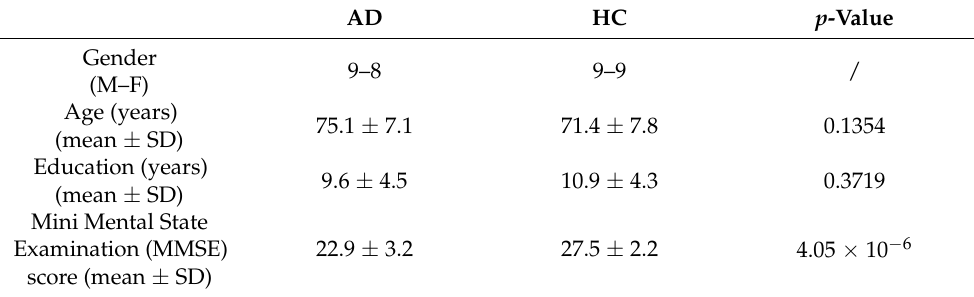
Table 1. Demographic information of Alzheimer’s disease (AD) and healthy controls (HC) involved in the